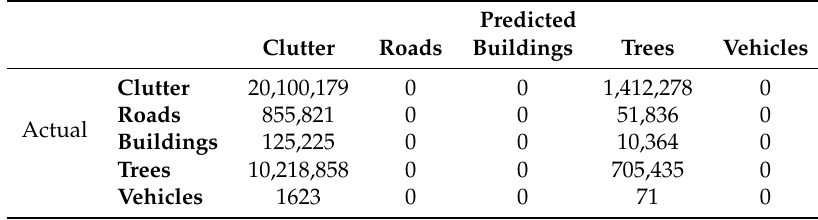
Table A4. Confusion matrix for the GSCNN model that is trained on coordinates and colors, after 50 epochs.